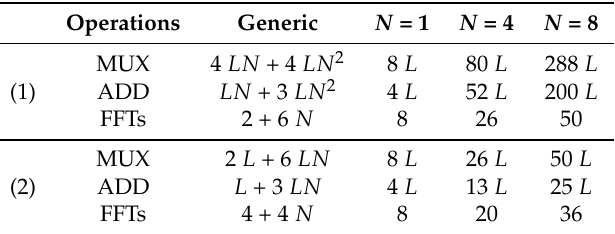
Table 2. Total number of multiplications (MUX), additions (ADD) and Fast Fourier Transforms (FFTs) per blockwise iteration of the FPBFxLMS algorithm in both: (1) centralized and (2) distributed ANC systems. L : length of the adaptive filters; N : number of nodes.